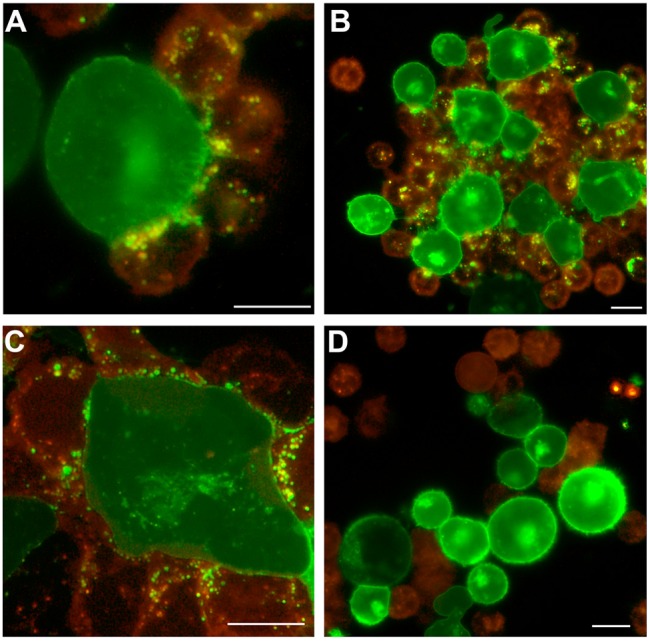
Fluorescence microscopy showing trogocytosis induced with 22*-(20)-(20).Purified monocytes labeled with PKH26-Red fluorescence were mixed 2∶1 with Daudi cells labeled with PKH67-Green fluorescence, and treated with 22*-(20)-(20) (A–C) or labetuzumab (D) at 10 µg/mL. Fluorescent images were captured after 30 min at room temperature with an Olympus BX66 microscope (Shinjuko, Tokyo, Japan) equipped with a Mercury-100W laser (Chiu Technical Corp., Kings Park, NY), using an Olympus 40X/0.75 air objective lens and a Kodak DC290 Camera (Rochester, New York) set at 115X zoom. A WB filter was used to allow simultaneous fluorescence of both red and green fluorochromes. Images were captured and processed using Adobe Photoshop CS3 v.10 software with a Kodak Microscopy Documentation System 290 plug-in application. Bars: 10 µm.